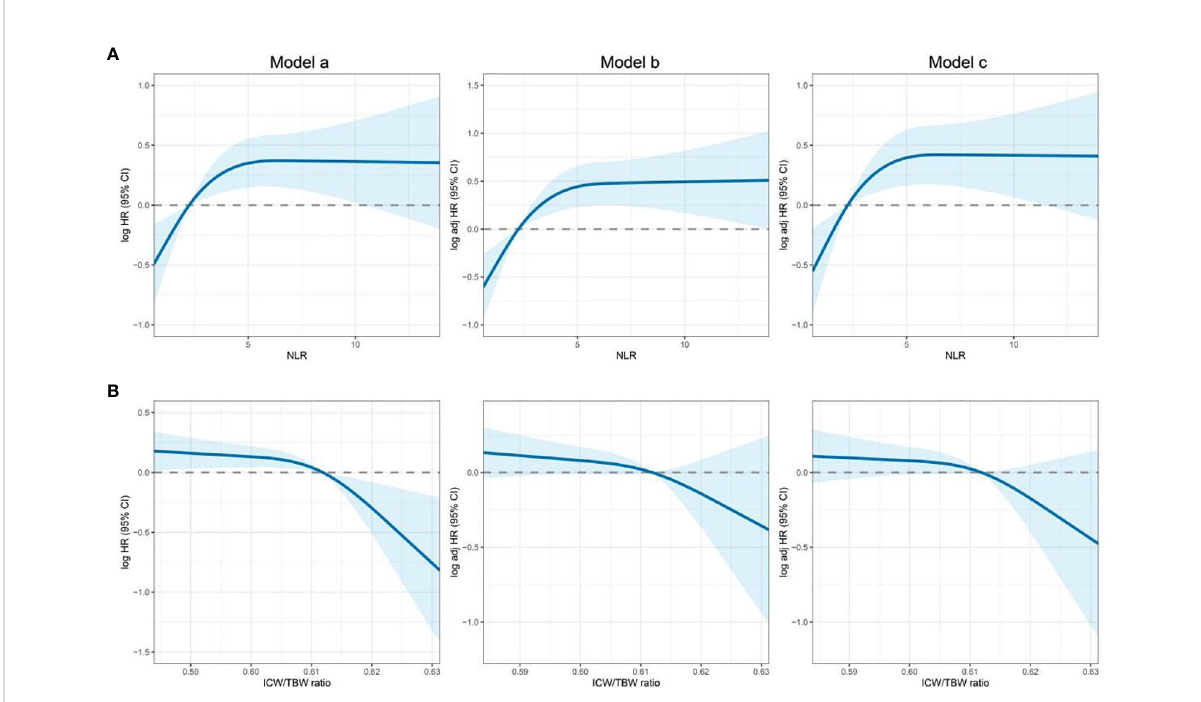
FIGURE 1 Association of the NLR and ICW/TBW ratio to all-cause mortality in patients with colorectal cancer. (A) - NLR, neutrophil-lymphocyte ratio; (B) - ICW/TBW ratio, intracellular water/total body water ratio. Model a: Crude model, Model b: Adjusted for age, sex, BMI, and TNM stage, Model c: Adjusted for age, sex, BMI, TNM stage, smoking, drinking, surgery, and